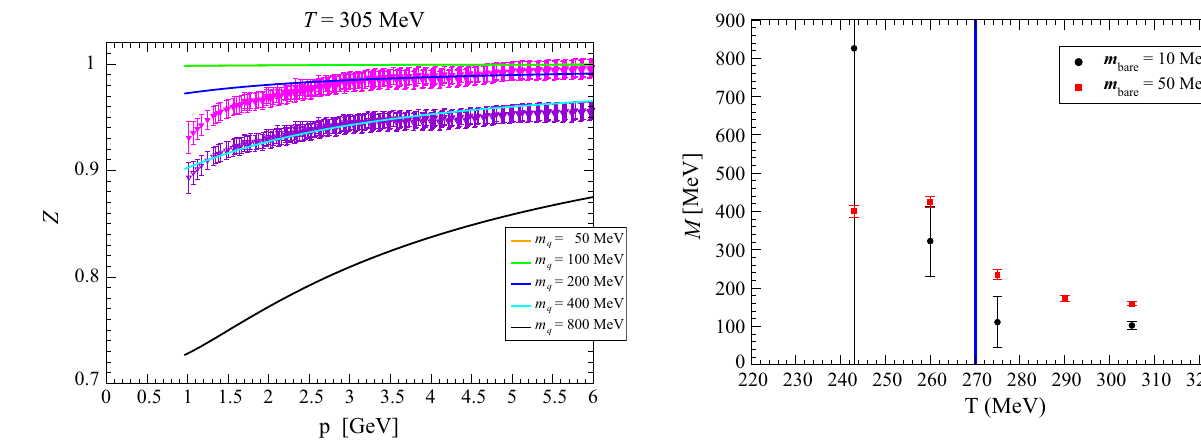
Fig. 8 Running quark mass at the smallest momenta for the various T considered in the current work. Note that the smallest momenta is temperature dependent and ranges from ∼ 0 . 8 GeV up to ∼ 1 GeV. The vertical blue line identifies the gluon deconfinement transition wave function and the HTL function are in good agreement for the full range of momenta. Our conclusion being that for T / T c = 1 . 13, the lattice data is in good qualitative agreement with HTL for the quark wave